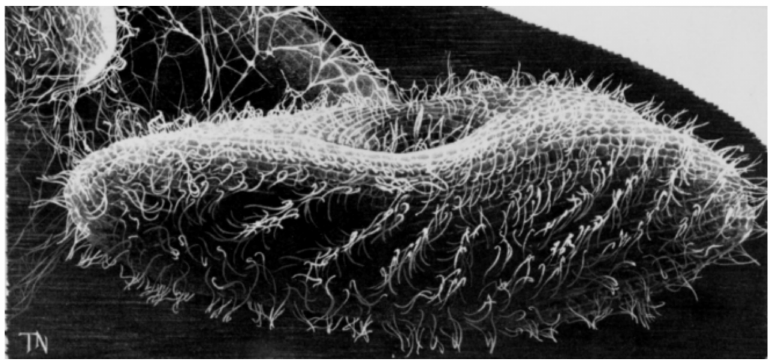
Figure 1. Line drawing from a scanning electron microscope image of P. tetraurelia. Courtesy of J. Van Houten and 1988 Grass Calendar.